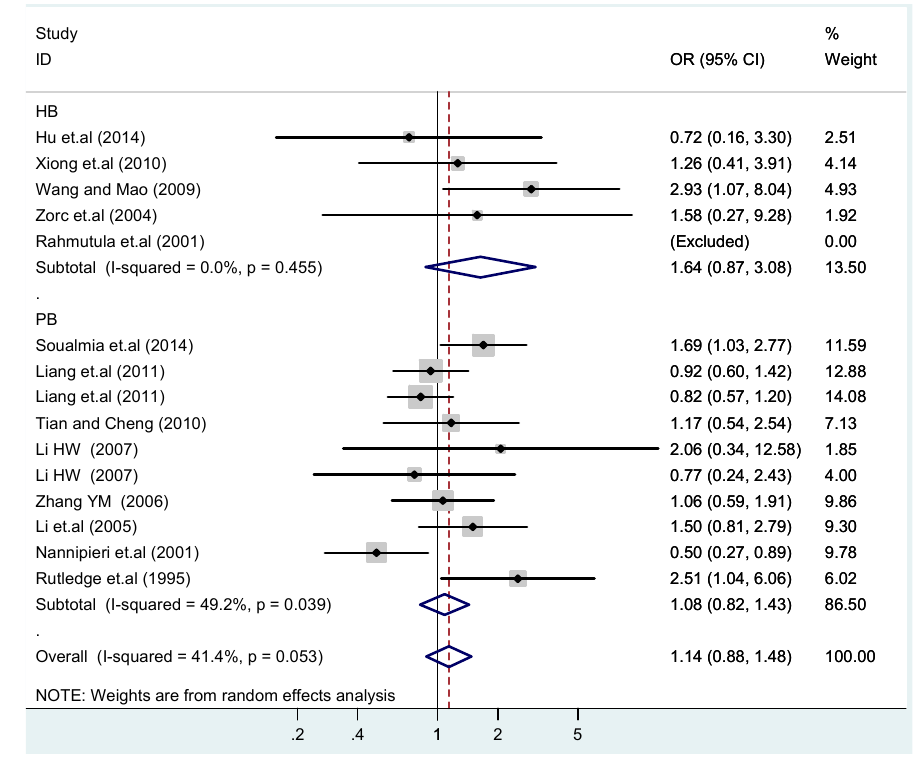
Figure 14. Subgroups in sources of controls of T2238C additive model (C vs. T).